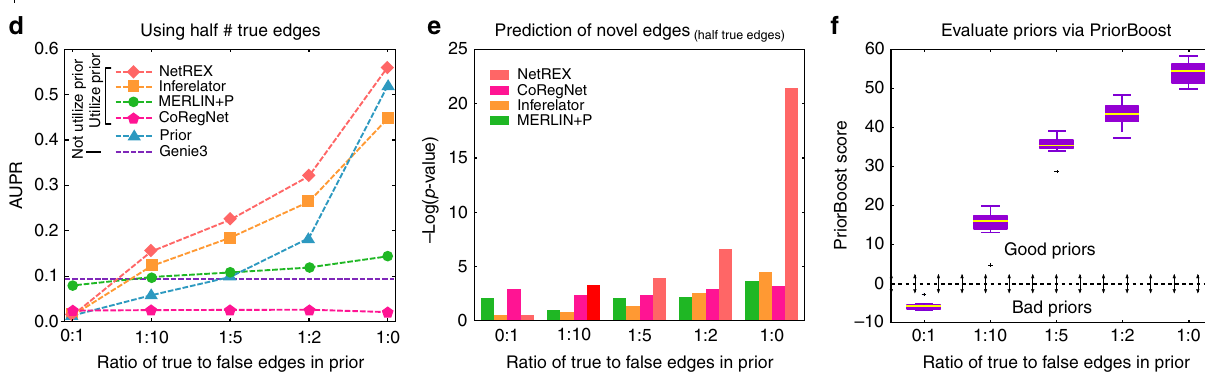
Fig. 2 Comparison of network inference methods based on E. coli data. a The performance measured in terms of AUPR as a function of the percentage of true edges in the prior. The total number of edges in the prior networks is fi xed and equal to the number of edges in the “ gold standard ” set. b Recovery of the novel TF-gene interactions ( x -axis same as a ). c PriorBoost scores ( x -axis same as a ). For each box in the boxplot, the central mark (white line) indicates the median, and the bottom and top edges of the box indicate the 25th and 75th percentiles, respectively. d – f Same as a – c but when the total number of true edges is fi xed and equal to half of the number of “ gold standard ” (given expression and priors). Figure 2c and f shows the robustness of PriorBoost scores for the perturbed prior networks (used by NetREX, Inferelator, MERLIN + P, and CoRegNet for Fig. 2a, b, d, e) with different noise levels. As demonstrated in Fig. 2c, f, PriorBoost scores correlate with the quality of the prior. In addition, a negative PriorBoost score correctly identi fi ed a